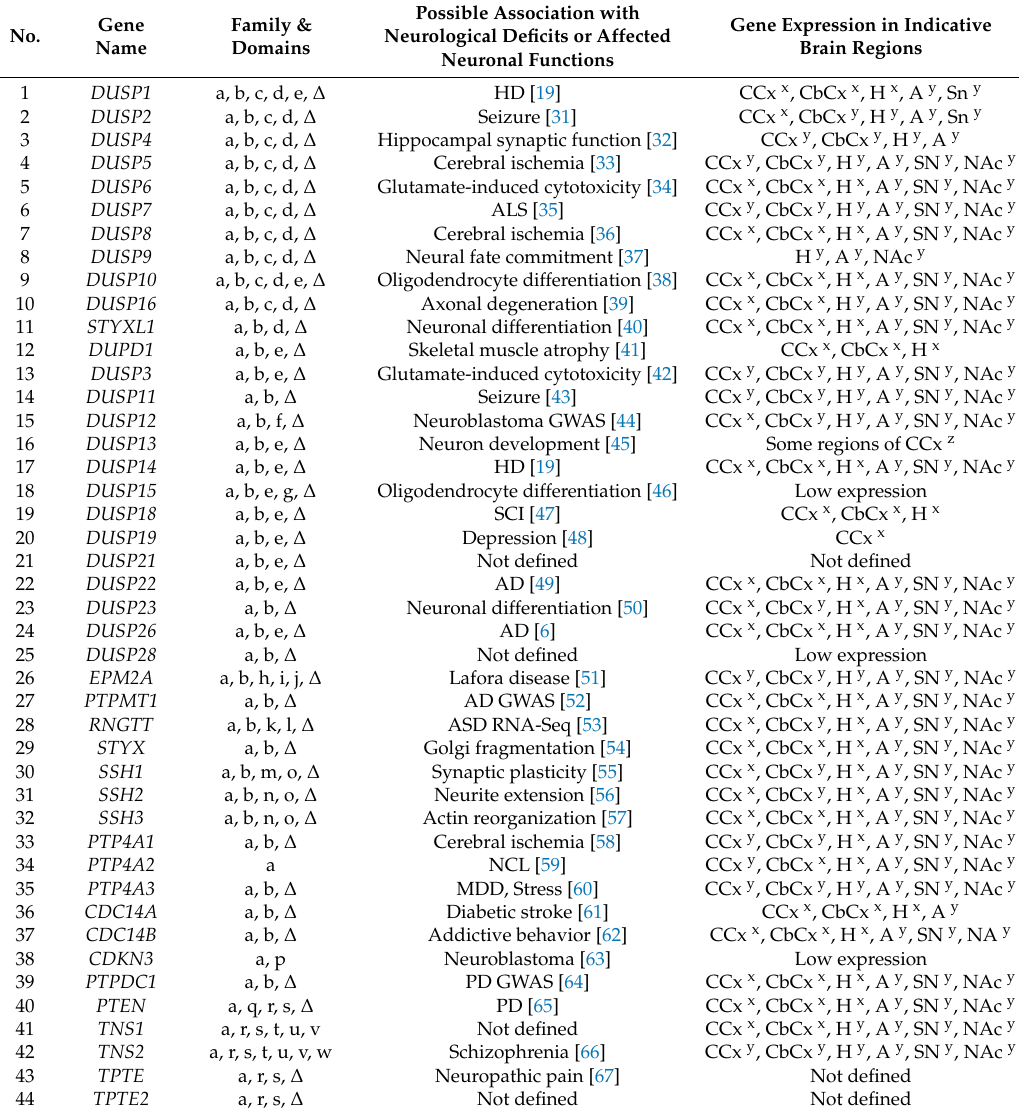
Table 1. The Correlation between Dysfunctional DUSP Members with Neural